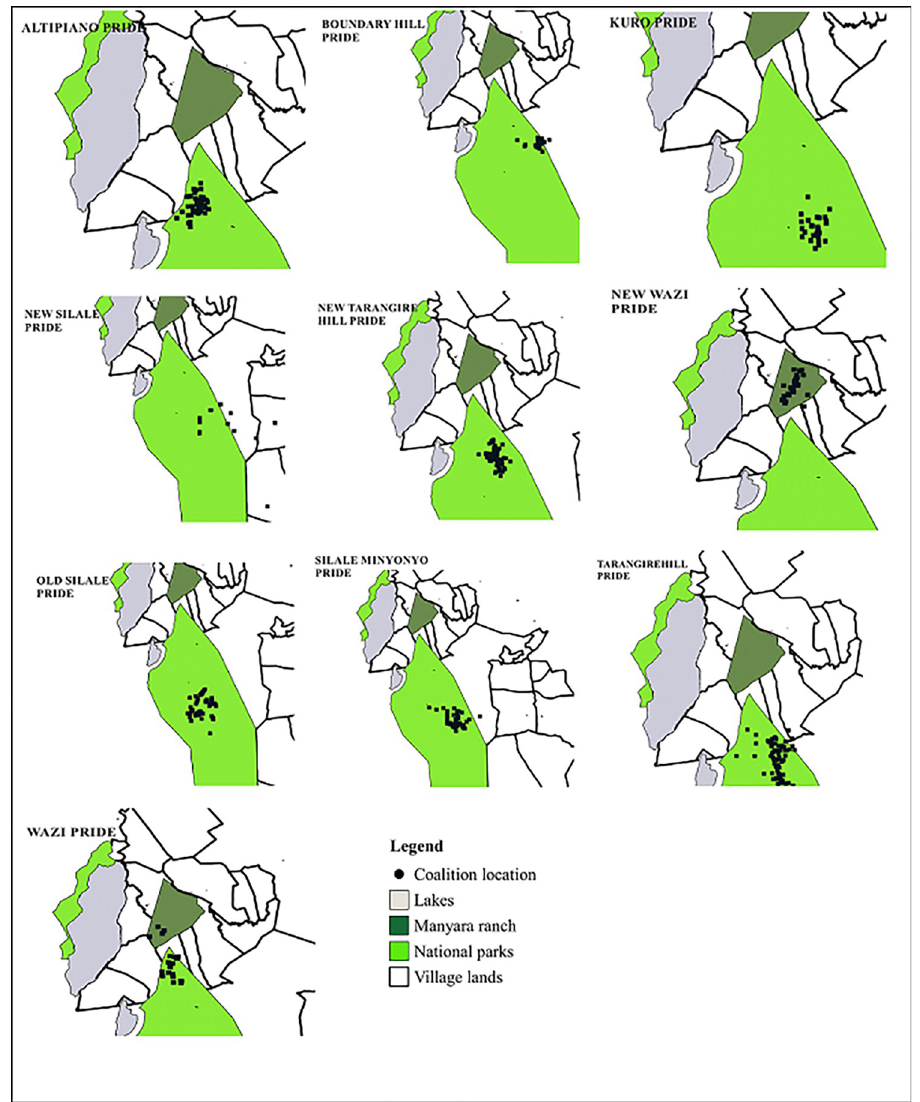
Fig 2. Coalition locations in the protected areas and surrounding villages. Protected areas are Manyara ranch- dark green color, National parks- light green color, lakes- grey color, village lands-plain box, coalitions location- black dots. Coalition coordinates for each pride from 2004 to 2018. Protected areas source shape files- Tarangire National park Database Shape files, Coalition coordinates source- Tarangire Lion Project. ‘Republished from [ref] under a CC BY license, with permission from [Tarangire Lion Project] copyright